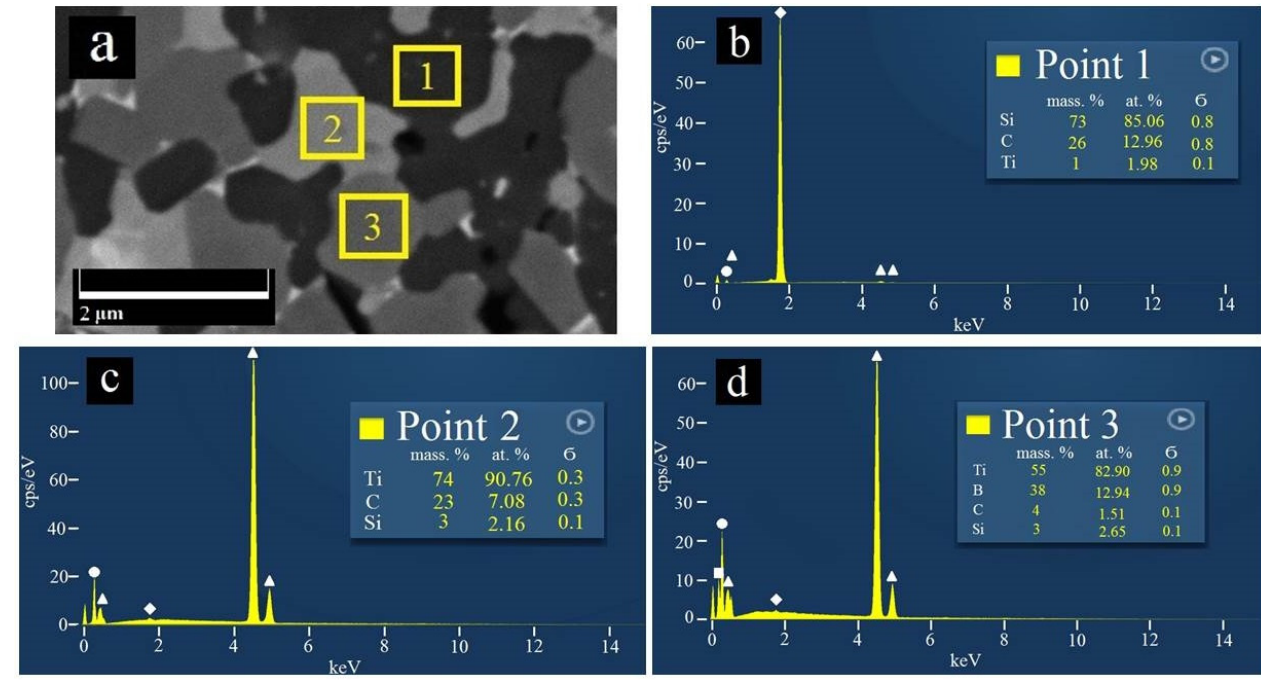
Figure 4. EDS analysis of 60 SiC composite: ( a ) SEM micrograph of polished surface, in which points 1, 2 and 3 show the places, where the spectra indicated in ( b – d ) were obtained, ( b ) the SiC spectrum, ( c ) the TiC phase, and ( d ) the TiB 2 material. In the images in ( b – d ), the elements Si, Ti, C, and B are represented by white rhombuses, triangles, circles, and squares, respectively.